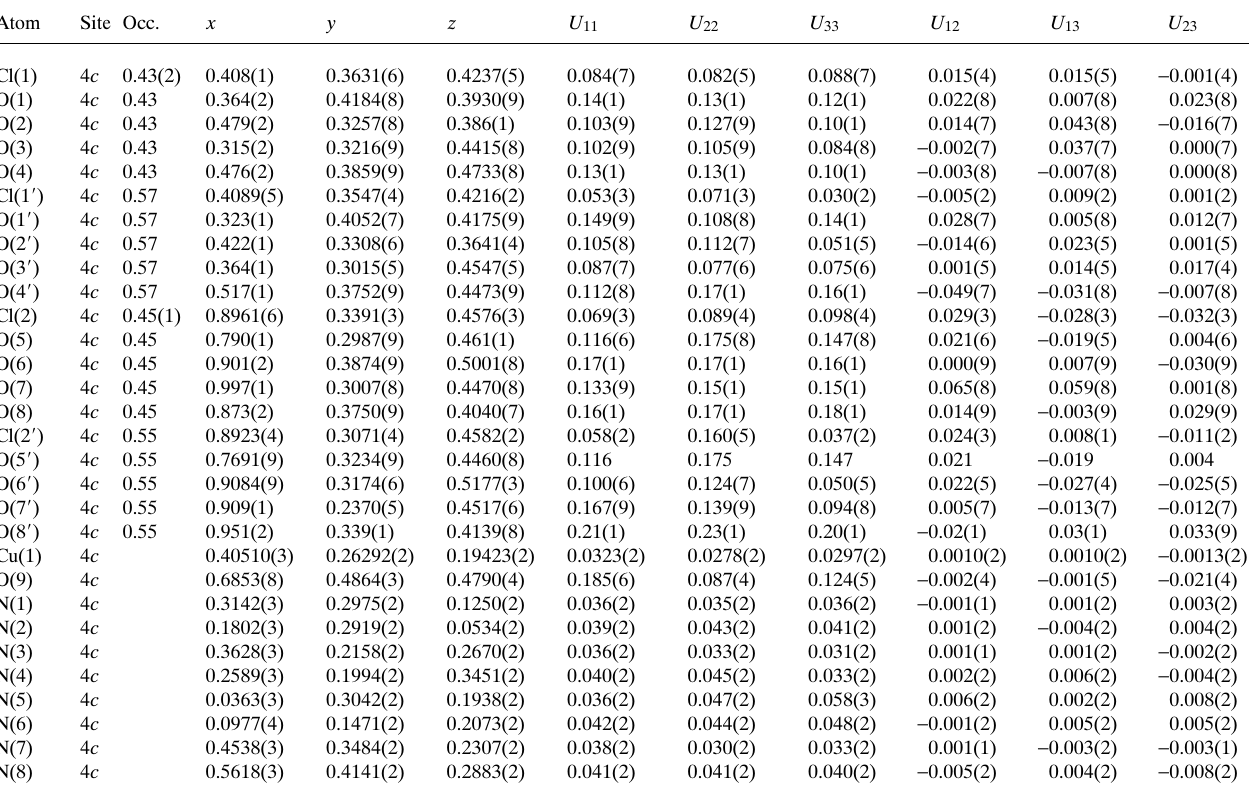
Table 3. Atomic coordinates and displacement parameters (in Å 2 ) .